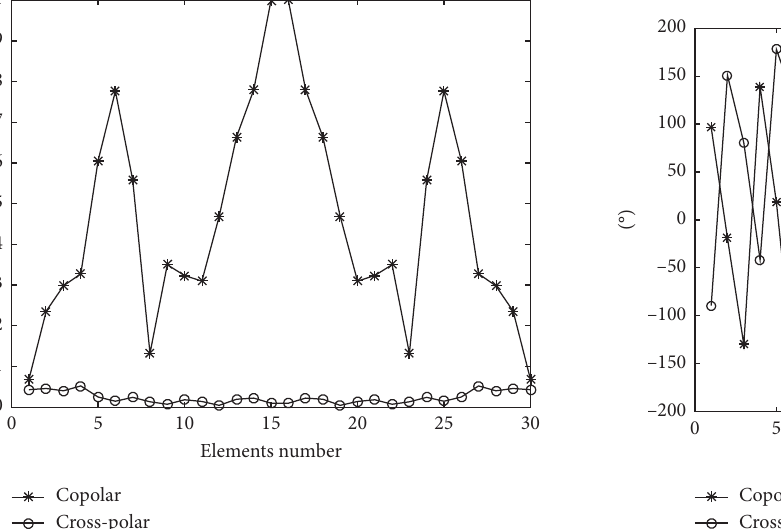
Figure 4: Flat-top-shaped beam synthesis of a 30-element array. (a) Copolarization component E at θ � 90 ∘ . component E θ